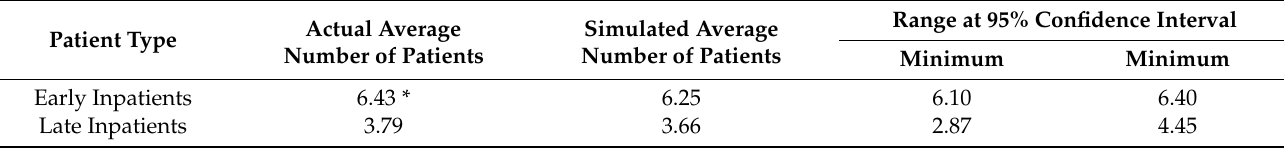
Table 9. Actual and simulated average number of inpatient arrivals based on probability